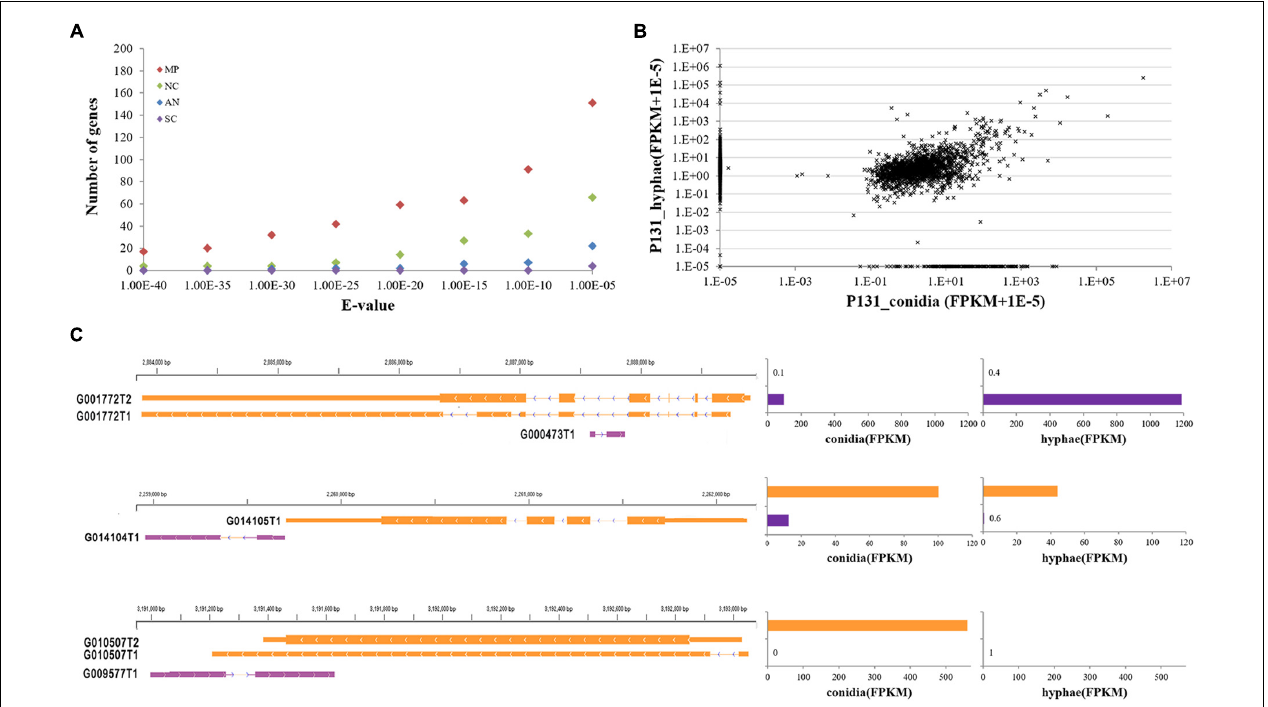
FIGURE 4 | Features of P. oryzae lncRNAs. (A) The number of putative non-coding genes with hits in other fungi by BLASTN searches. MP, Magnaporthe poae ; AN, Aspergillus nidulans ; NC, Neurospora crassa ; SC, Saccharomyces cerevisiae . (B) Expression levels of putative non-coding RNA transcripts in conidia and hyphae. Expression levels of each lncRNA are represented by FPKM. (C) Examples showing the expression of lncRNAs in relation to their neighboring genes, i.e., G001772 (MGG_16180), G014105 (MGG_04005), and G010507 (MGG_06585). The assembled transcript number for each gene was appended to gene id.